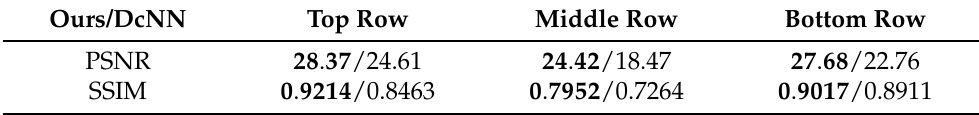
Table 3. Comparison of the average PSNR and SSIM between the proposed method and DcNN based method in MATLAB.